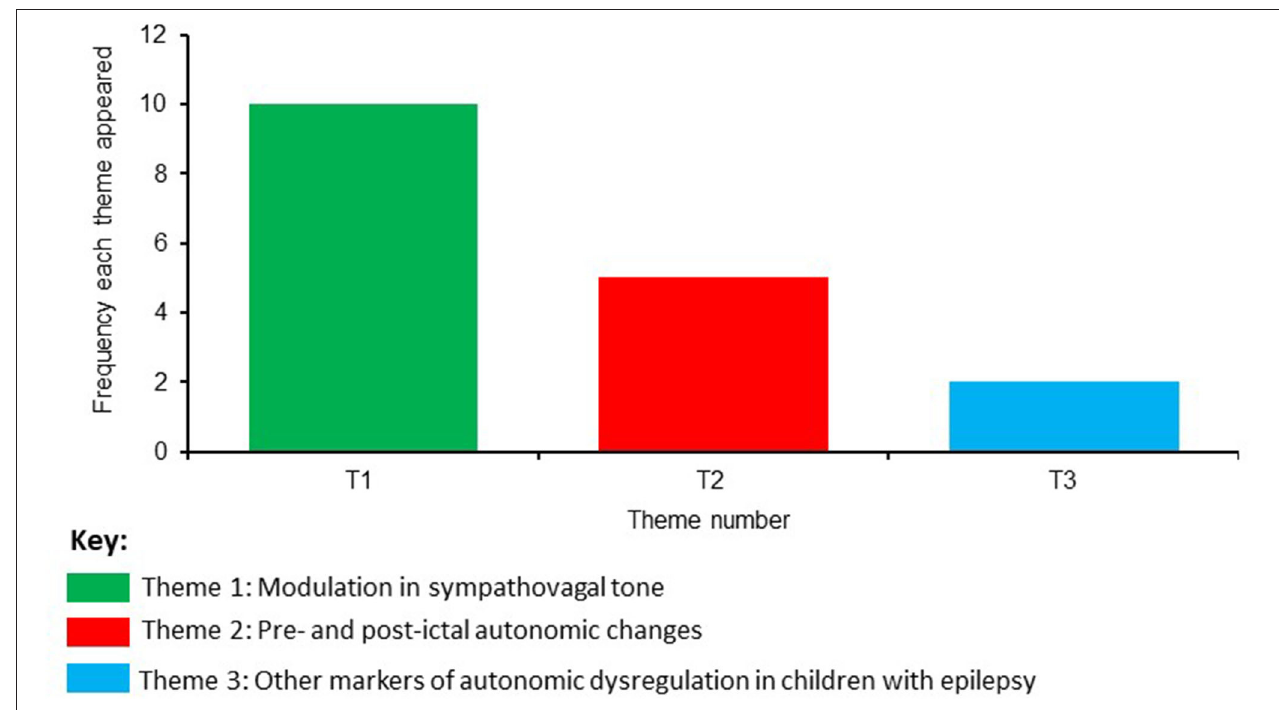
FIGURE 2 | Frequency of identified